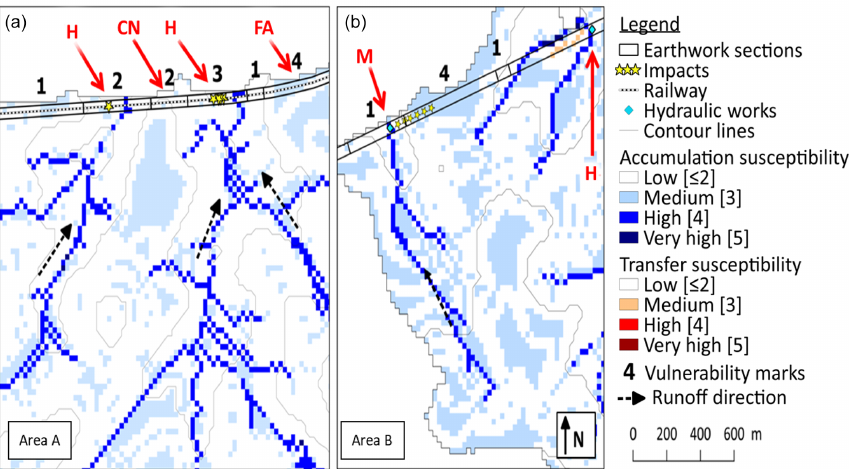
Figure 7. Illustration of the evaluation area and of the building of contingency tables on two sub-areas: (a) Area A and (b) Area B. The evaluation area is the buffer (black contours) along the railway line (black dotted line). This is divided into sections (earthwork sections) to which a vulnerability score is assigned (black numbers in the figure). Impacts are the yellow stars. Hydraulic infrastructures are marked with blue diamonds. IRIP susceptibility levels appear in red for transfer and blue for accumulation (only levels 3, 4 and 5 are drawn in the figure). Red arrows show the value assigned to the railway sections in the contingency table, where H means hit, CN means correct negative, M means miss and FA means false